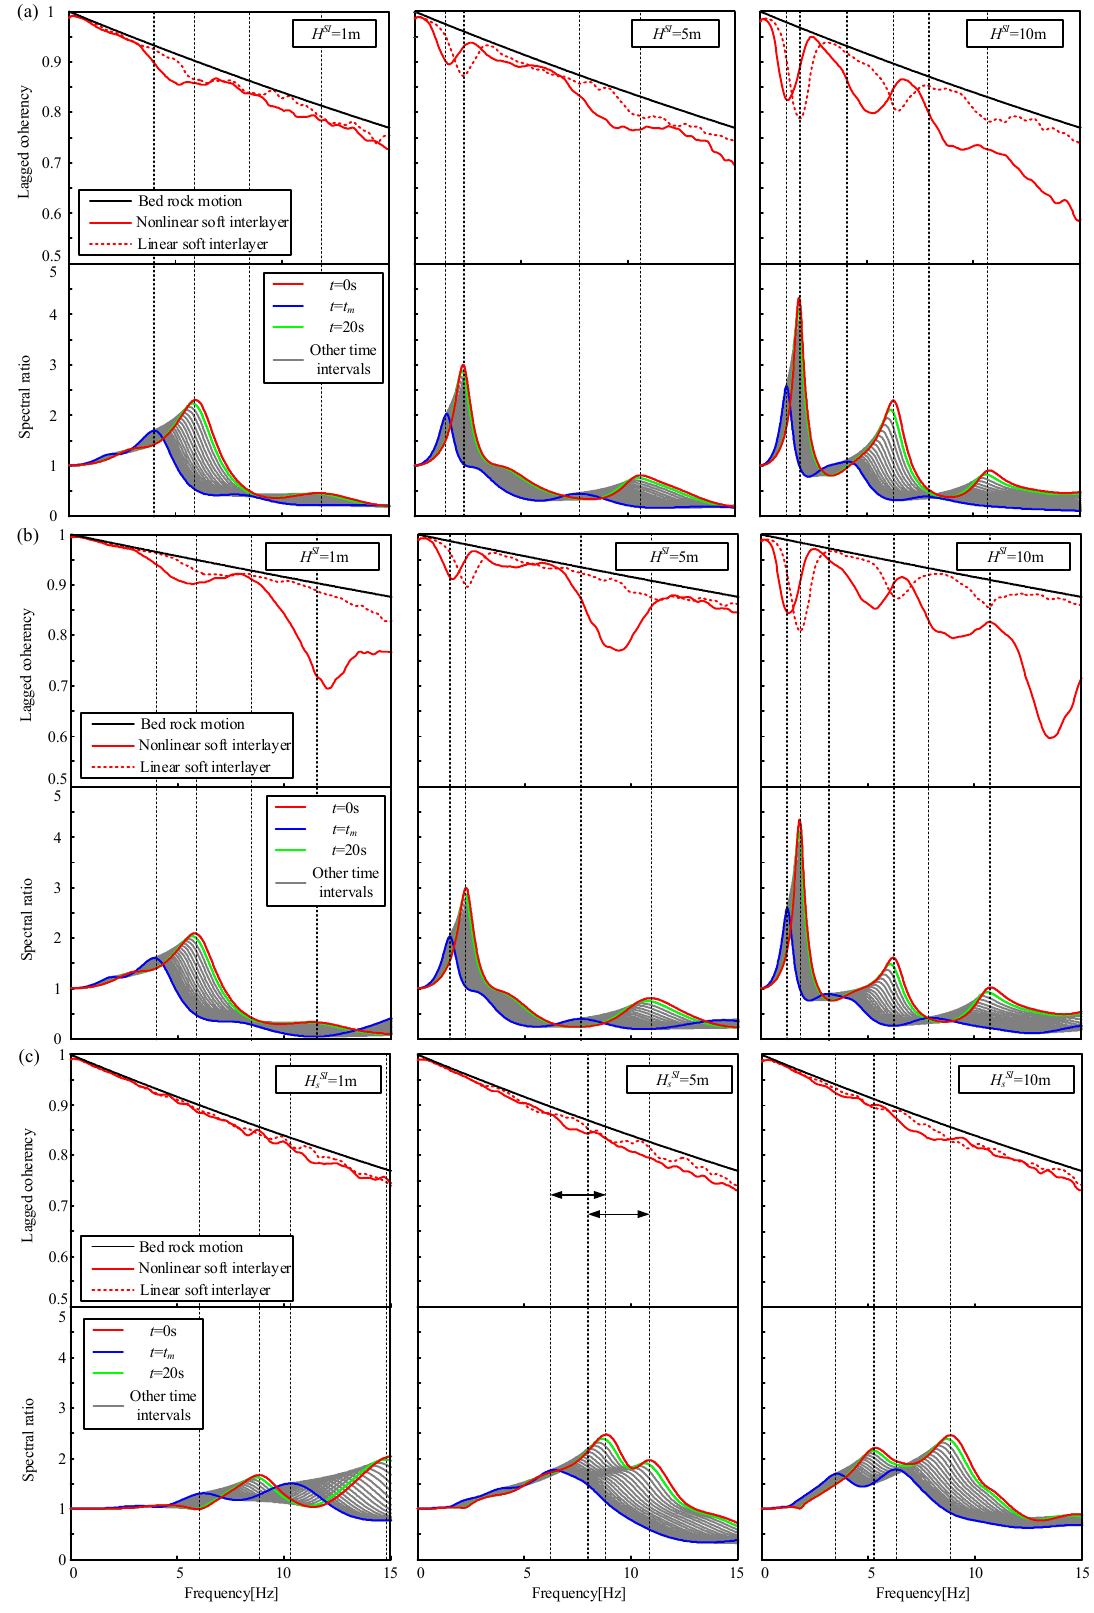
Figure 12. Mean lagged coherency and corresponding time-varying spectral ratios for ( a ) horizontal out-of-plane motions; ( b ) horizontal in-plane motions; and ( c ) vertical in-plane motions under varying thickness of soft interlayer.